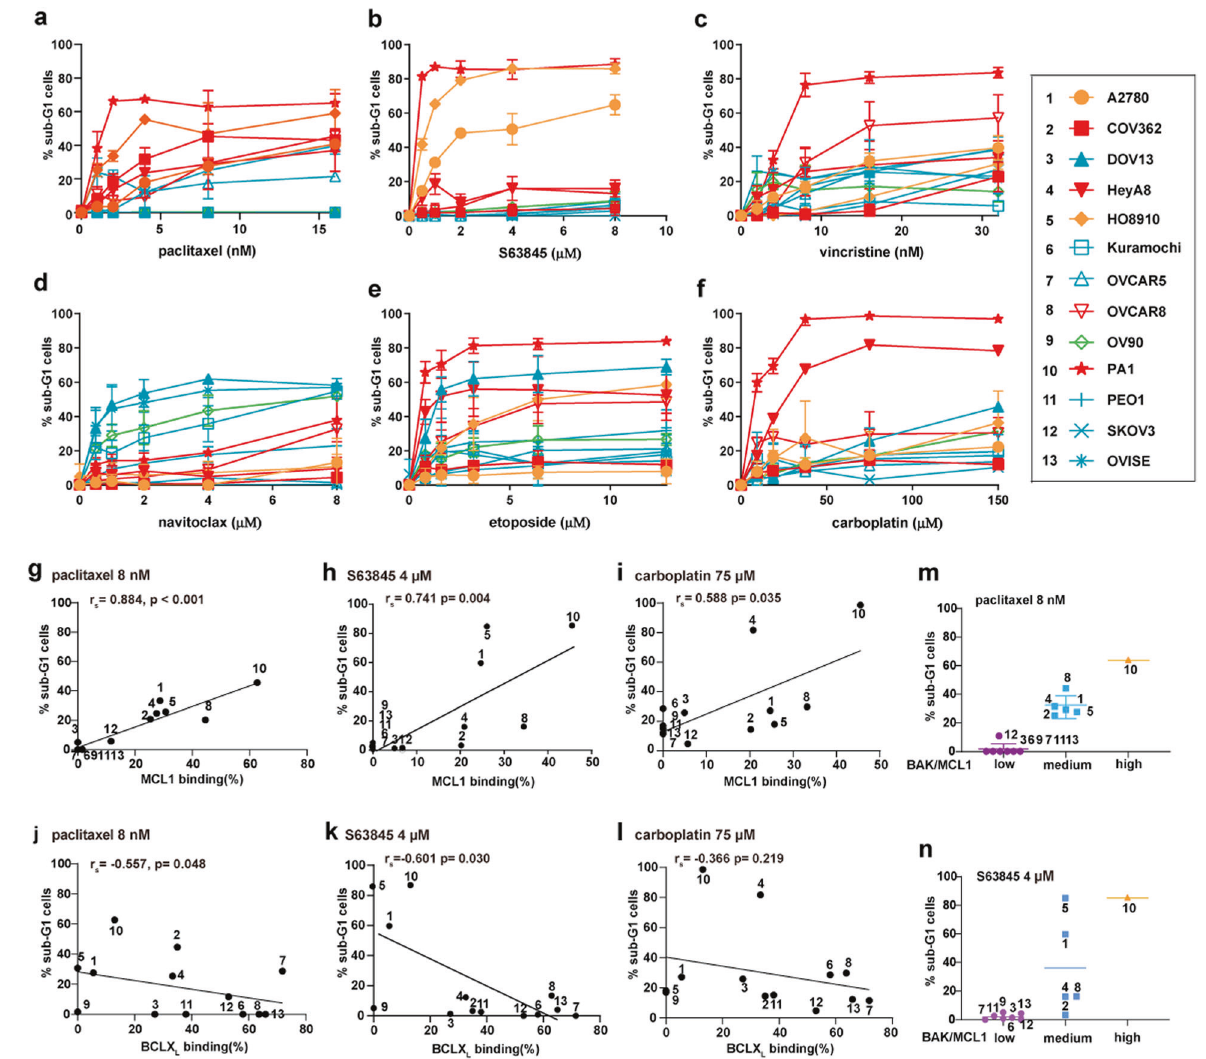
Fig. 2 Preformed BAK/MCL1 complexes predict cancer cell sensitivity to paclitaxel and S63845. a – f After the cell lines were treated with paclitaxel ( a ), S63845 ( b ), vincristine ( c ), navitoclax ( d ), etoposide ( e ), or carboplatin ( f ) for 48 h, the percentages of sub-G1 cells were assessed by fl ow cytometry ( n = 3 – 5 independent experiments, means ± S.D.). Cells with BAK status classi fi ed as BAK/MCL1, BAK/BCLX L , BAK/MCL1 + BAK/BCLX L , and none are indicated with orange, blue, red, and green, respectively. The numbers before each cell line in the Inset will be used to represent the cell lines in Figs. 2, 4, 5, and Supplementary Figs. 4 and 7. g – i The correlations of BAK/MCL1 complexes and cell death induced by paclitaxel 8 nM ( g ), S63845 4 μ M ( h ), and carboplatin 75 μ M ( i ) were analyzed using Spearman rank correlation, respectively. j – l The correlations of BAK/BCLX L complexes and cell death induced by paclitaxel 8 nM ( j ), S63845 4 μ M ( k ), and carboplatin 75 μ M ( l ) were analyzed using Spearman rank correlation, respectively. m , n Cell lines were grouped into three different groups according to the percentage of BAK bound to MCL1 (BAK/MCL1), and the apoptosis induced by paclitaxel 8 nM ( m ), or S63845 4 μ M ( n ) was indicated for each cell line. each BCL2 family member at the mRNA level. This analysis When the relationships between BCL2 family protein expression indicated that ovarian cancers with high BCLX L mRNA in GEPIA and the induction of apoptosis by anticancer drugs were examined, MCL1 and BCL2 levels were found to correlate with tended to have shorter survival, and patients with high PUMA carboplatin-induced cell death, while BCL2 and NOXA levels were mRNA in Kmplot tended to be associated with shorter survival found to correlate with etoposide-induced cell death (Supple- (Supplementary Fig. 6c, d). To further focus on the ovarian cancer mentary Fig. 6b). However, the protein levels were not found to patients treated with paclitaxel and to rule out a possible correlate with cell deaths induced by paclitaxel, S63845, vincris- in fl uence by radiotherapy, a total of 59 ovarian cancer patients tine, navitoclax, olaparib, topotecan, 5-FU, or A1210477 (Fig. 4d who received paclitaxel treatment but did not receive radio- and Supplementary Fig. 6b). therapy from the TCGA database were analyzed. No signi fi cant To examine whether mRNA levels of BCL2 family proteins could correlation between the mRNA level of the BCL2 family and overall be a predictive marker for ovarian cancer treatment ef fi cacy, survival was observed in this group of patients (Fig. 4e). ovarian cancer patient data from gene expression pro fi ling Taken together, these data suggest that the presence of interactive analysis (GEPIA) and Kmplot (Kaplan Meier Plot) constitutive BAK/MCL1 binding might be a better marker than databases were obtained, and overall survival was analyzed single BCL2 family protein expression or mRNA expression for the between groups with high expression versus low expression of prediction of paclitaxel sensitivity.